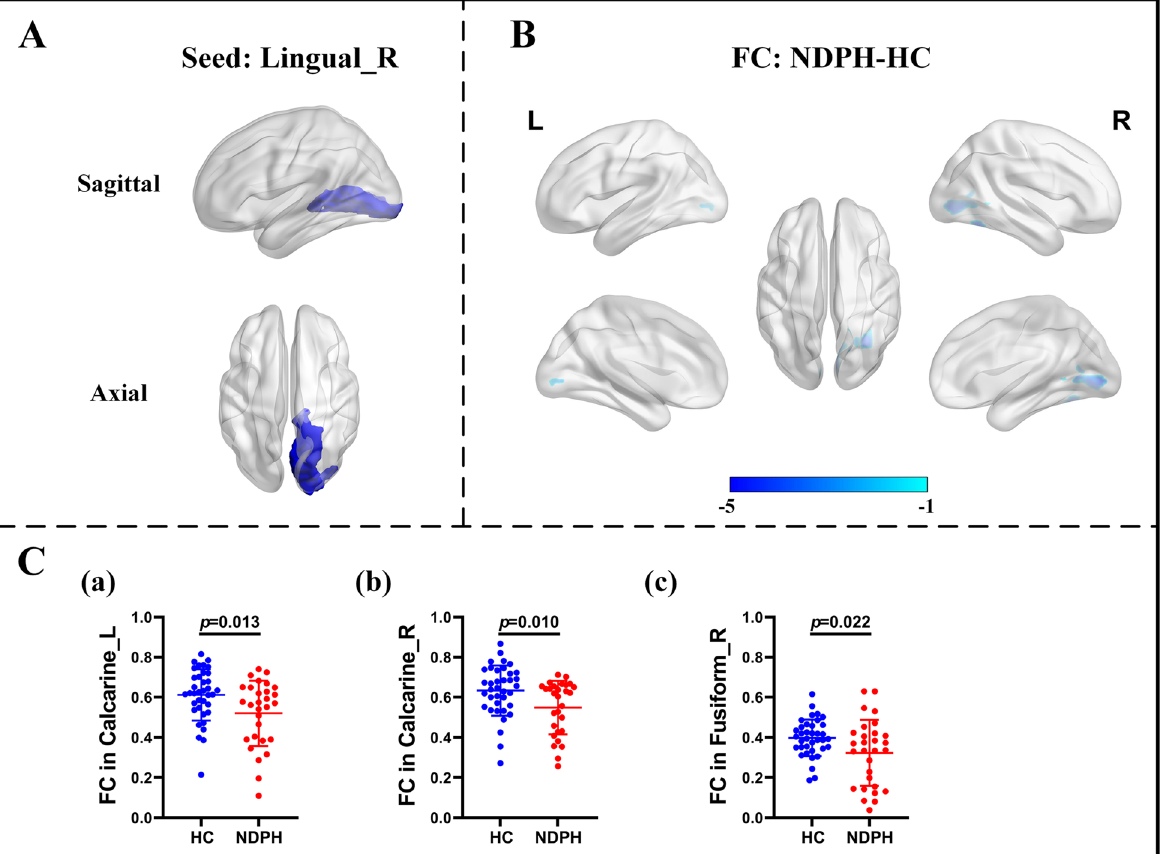
Fig. 1 FC analysis from right lingual gyrus to the whole brain voxels in NDPH and HC groups. A The schematic diagram of the seed (right lingual gyrus). The brain region marked in blue represents the right lingual gyrus. B The schematic diagram of significant FC differences. Compared with HCs, patients with NDPH show significantly decreased FC between the seed and bilateral calcarine, right fusiform gyrus. C (a), (b) and (c) represent FC values between the right lingual gyrus and bilateral calcarine, right fusiform gyrus respectively in HC group and patients with NDPH. Notes: The color bar showed t-values of the two-sample t-tests on FC. Abbreviations: L, left; R, right; FC, functional connectivity; NDPH, new daily persistent headache; HC, health